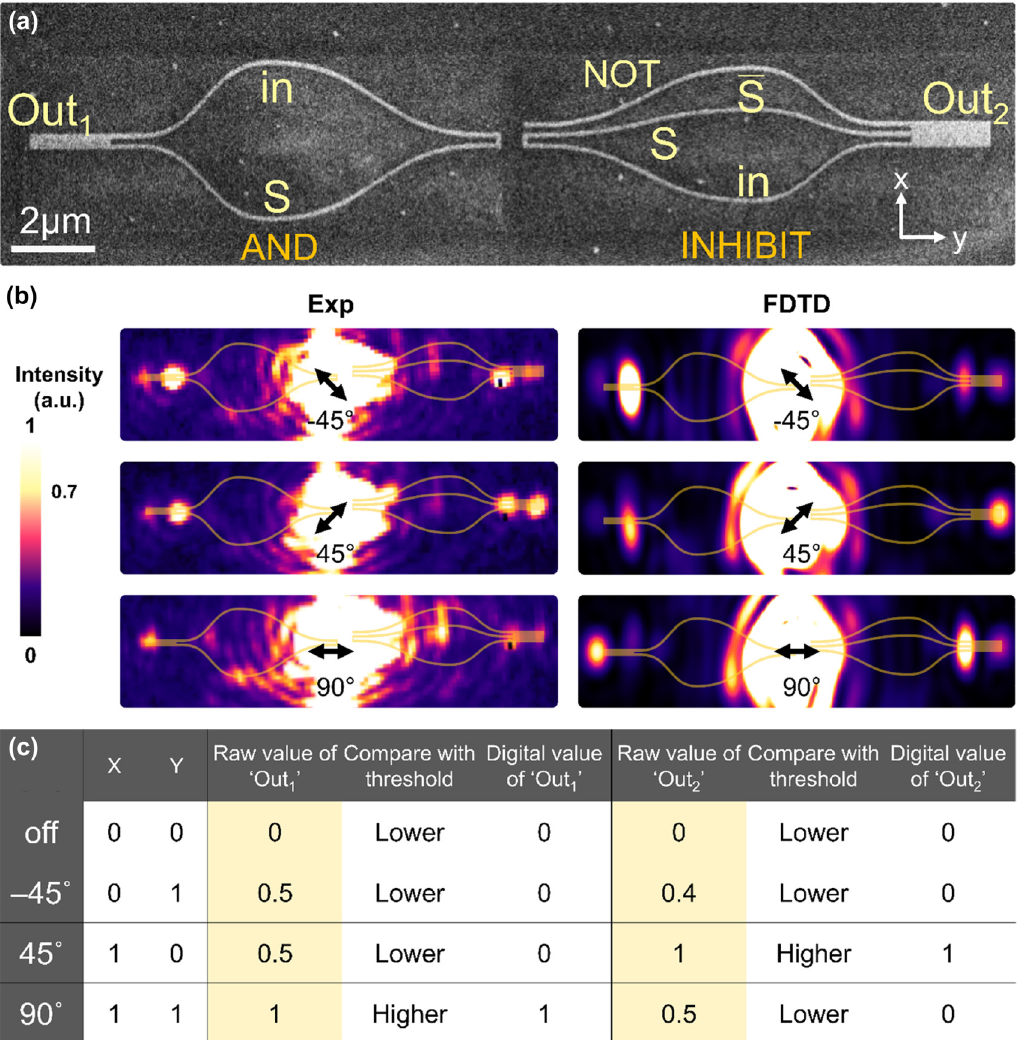
Figure 4: Experimental demonstration of a plasmonic demultiplexer. (a) The SEM image of the demultiplexer. The dashed circle denotes the input laser beam position. (b) The experimental (Exp) and simulation (FDTD) results. The input (in) digit value is distributed to the output of ) when S is ‘1’. These are accomplished for laser polarized in − 45 ◦ and 90 ◦ . On the other hand, the input (in) digit value is the AND gate (Out 1 ) when S is ‘0’. This is achieved for laser polarization 45 ◦ . (c) The experimental truth distributed to the output of the INHIBIT AND gate (Out 2 table of the plasmonic